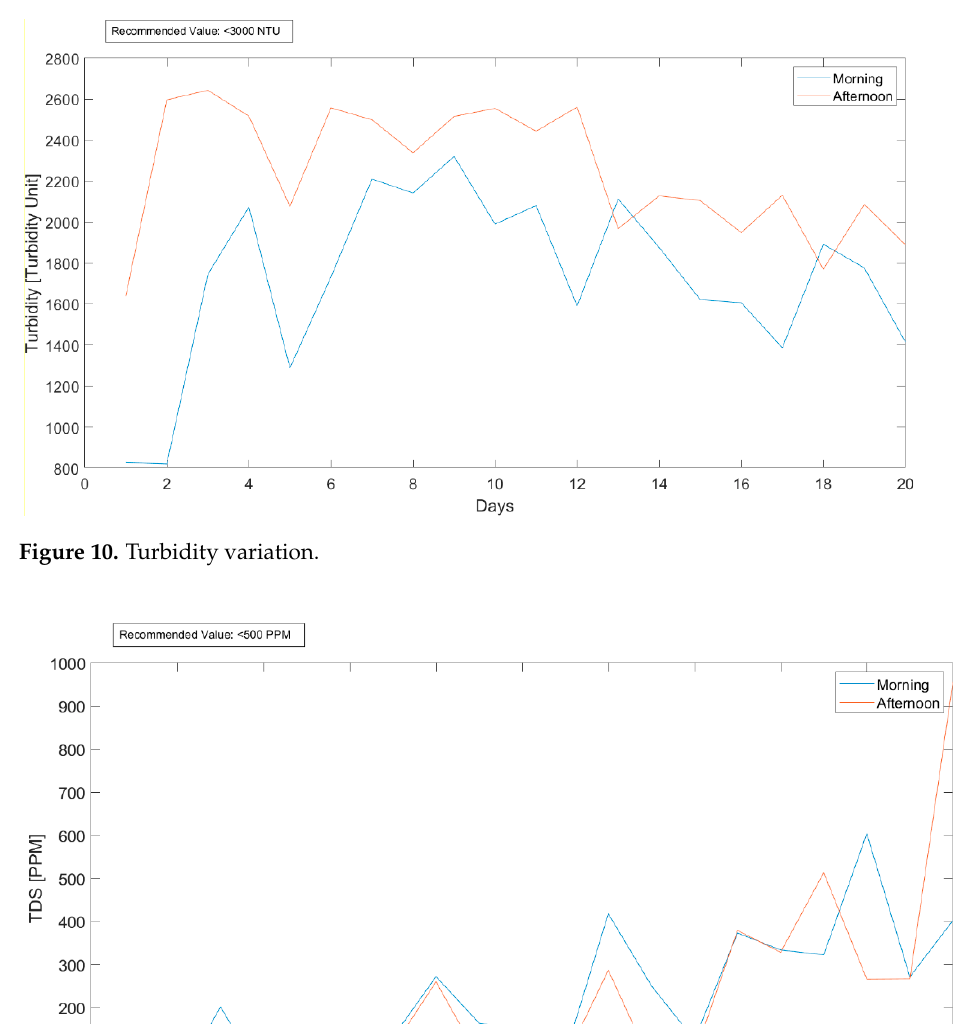
Figure 9. Temperature variation. 273